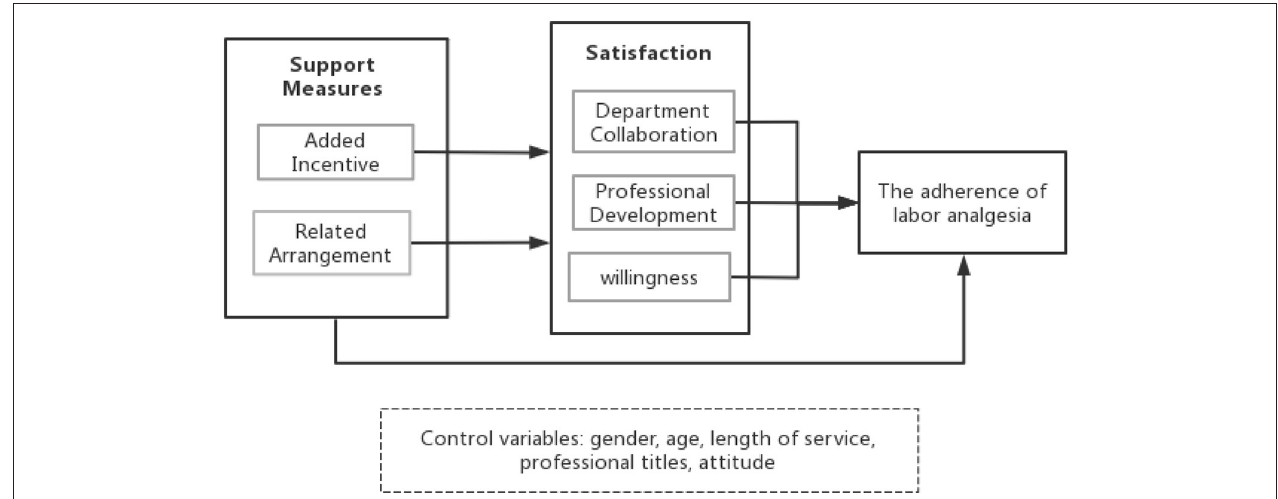
FIGURE 1 | Conceptual